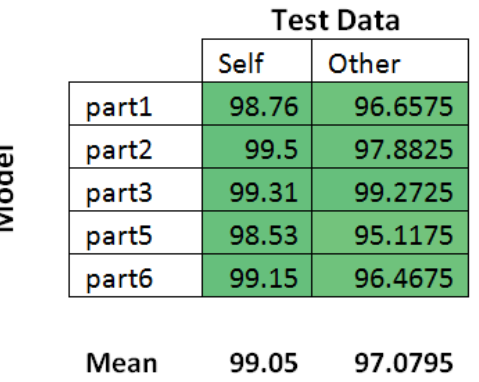
Figure 5. Final mean accuracy